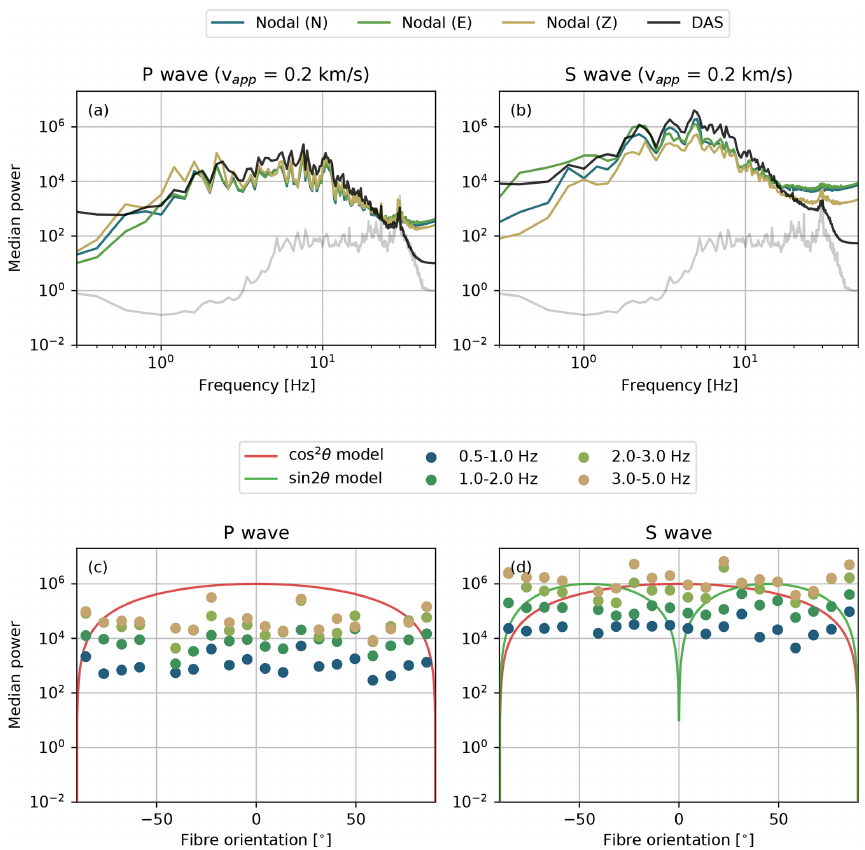
Figure 2. (a–b) Median power spectral densities of the nodal and DAS arrays for the P wave and S wave. The nodal seismometer recordings are converted into acceleration spectra, which are proportional to the DAS strain rate spectra. The proportionality constant (the apparent phase velocity) is taken as 0.2kms − 1 . The noise floor is shown as a grey band; (c–d) mean power in selected frequency bins as a function of the fibre-optic cable orientation with respect to the back-azimuth of the seismic source. The theoretical sensitivities (Martin et al., 2018) are included for